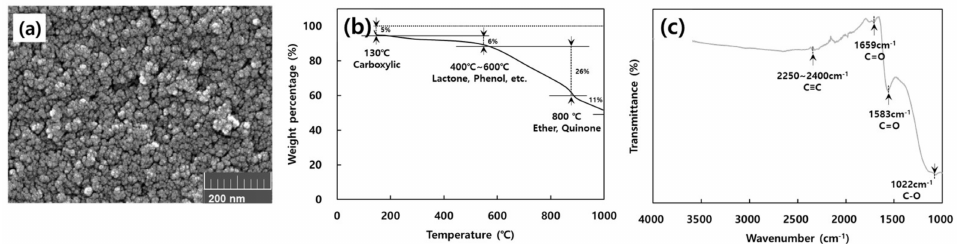
Figure 2. ( a ) Scanning electron microscopy (SEM) image, ( b ) TGA weight percentage curve, and ( c ) spectrogram of activated